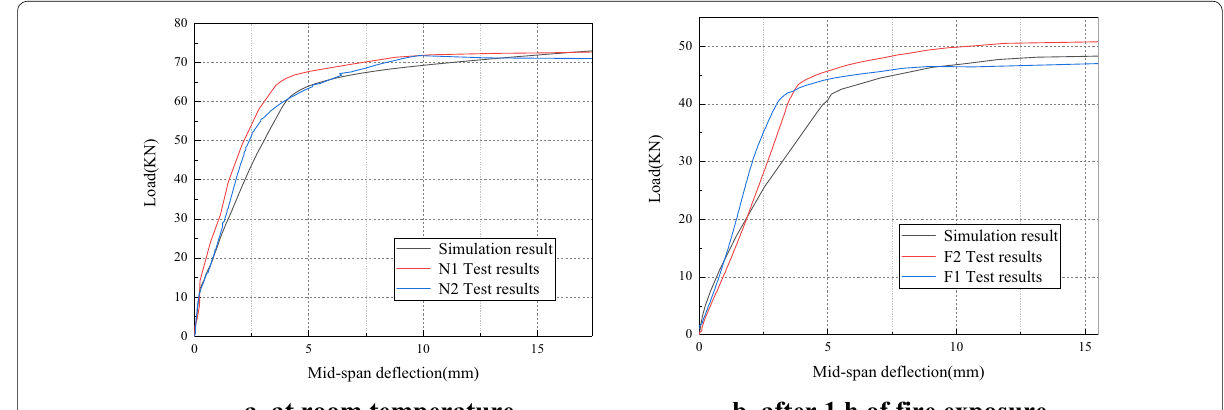
Fig. 17 Tested and simulated load–deflection